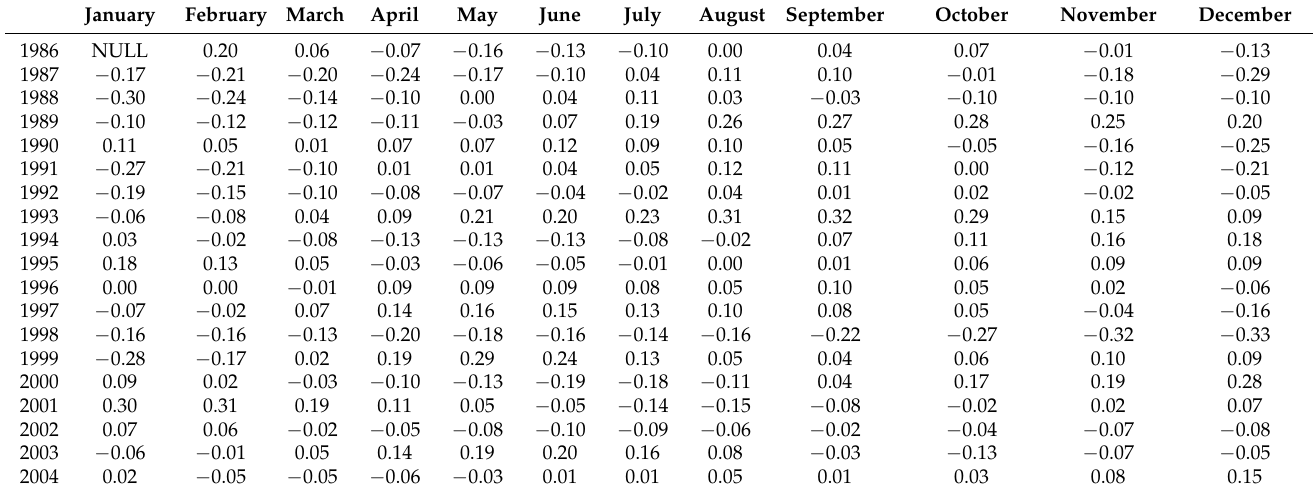
Table A3. Derived monthly Fresh Fruit Bunch Index (FFBI) in tons per hectare from February 1986 to June 2021 in